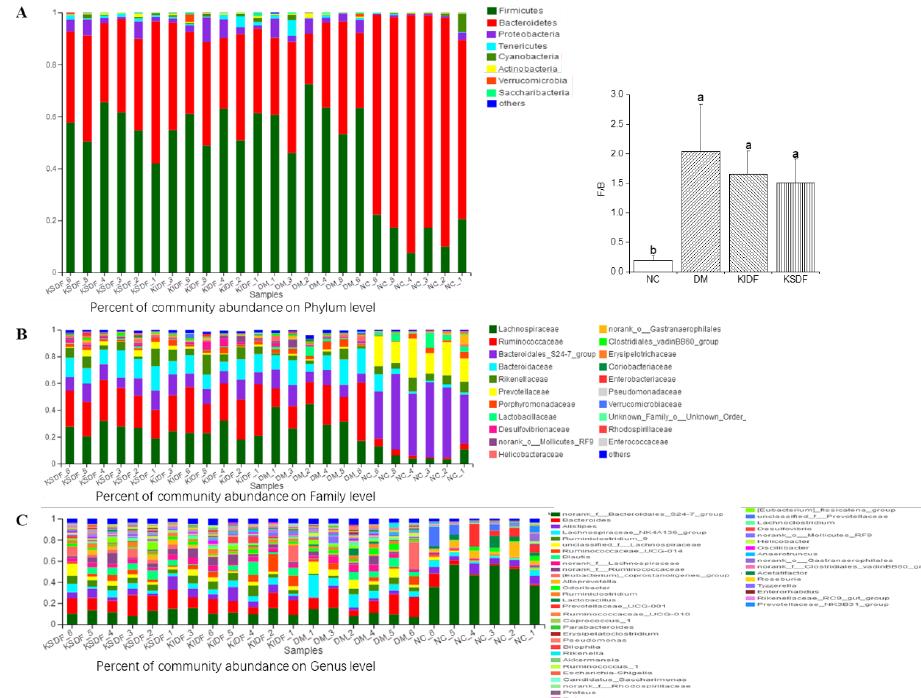
Figure 3. The relative abundance of gut microbiota at the phylum, family, and genus levels. Effects of NC, DM, KIDF and KSDF on the percentage of community abundance on ( A ) phylum, ( B ) family, and ( C ) genus levels. The diverse letters represent a significant difference ( p < 0.05). F/B, Firmicutes/Bacteroidetes.